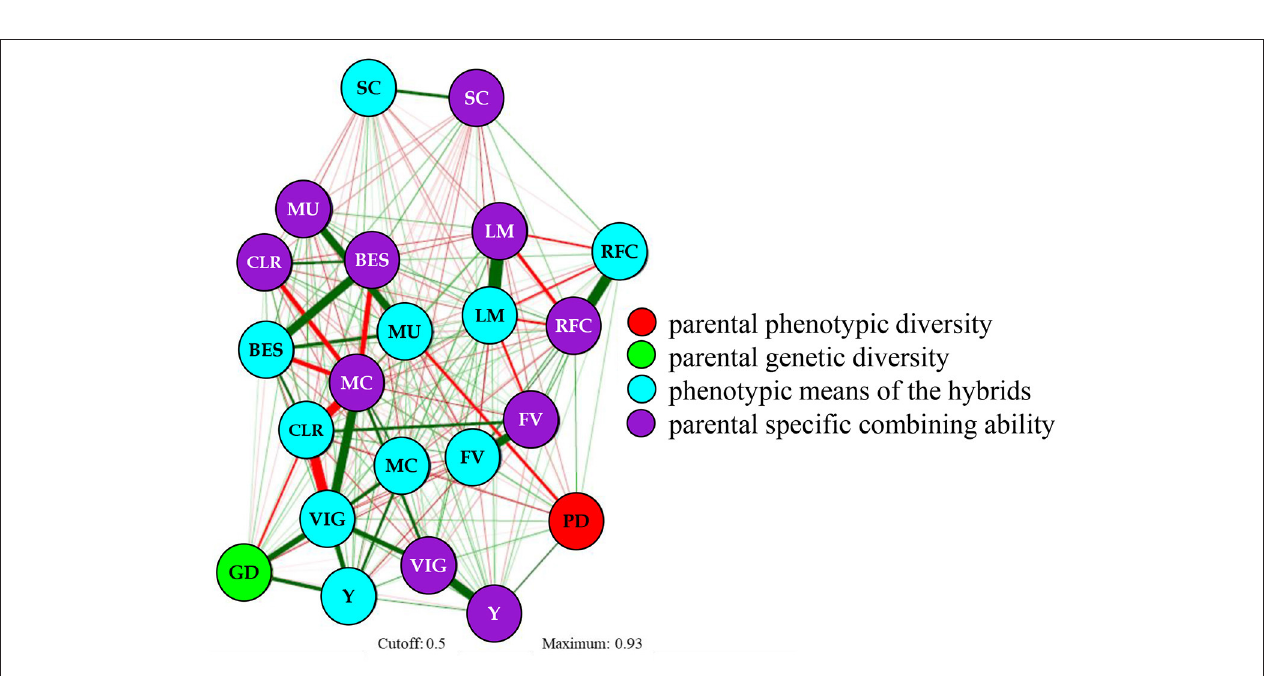
FIGURE 4 | Network correlation showing the relationship among the phenotypic diversity (PD) of the diallel parents, the genetic diversity (GD) of the parents based on SSR markers, the mean performance of the hybrids for each trait, and the specific combining ability. Evaluated traits: vegetative vigor (Vig), sprout color (SC), ripening fruit color (RFC), yield (Y), maturation cycle (MC), maturation uniformity (MU), ripening fruit size (RFS), incidence of coffee leaf rust (CLR), incidence of brown eye spot (BES), and leaf miner infestation (LM). The green lines correspond to the positive correlations and the red lines to the negative correlations. The width of the line is proportional to the intensity of the